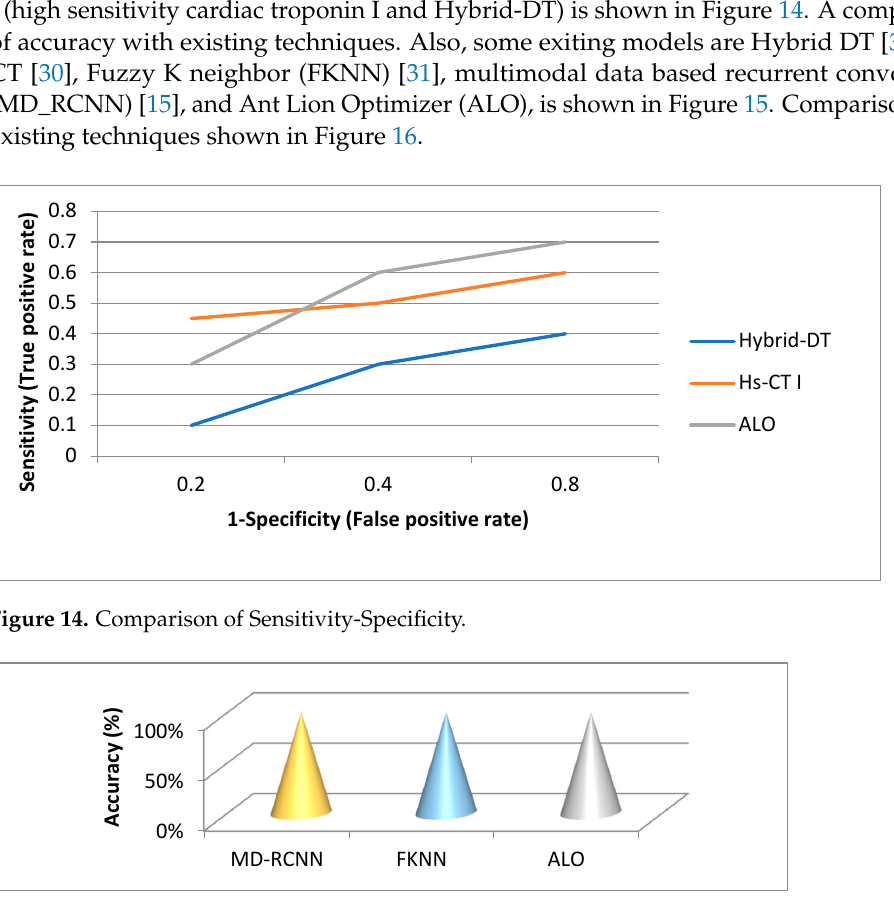
Figure 15. Comparison of Accuracy with existing techniques.